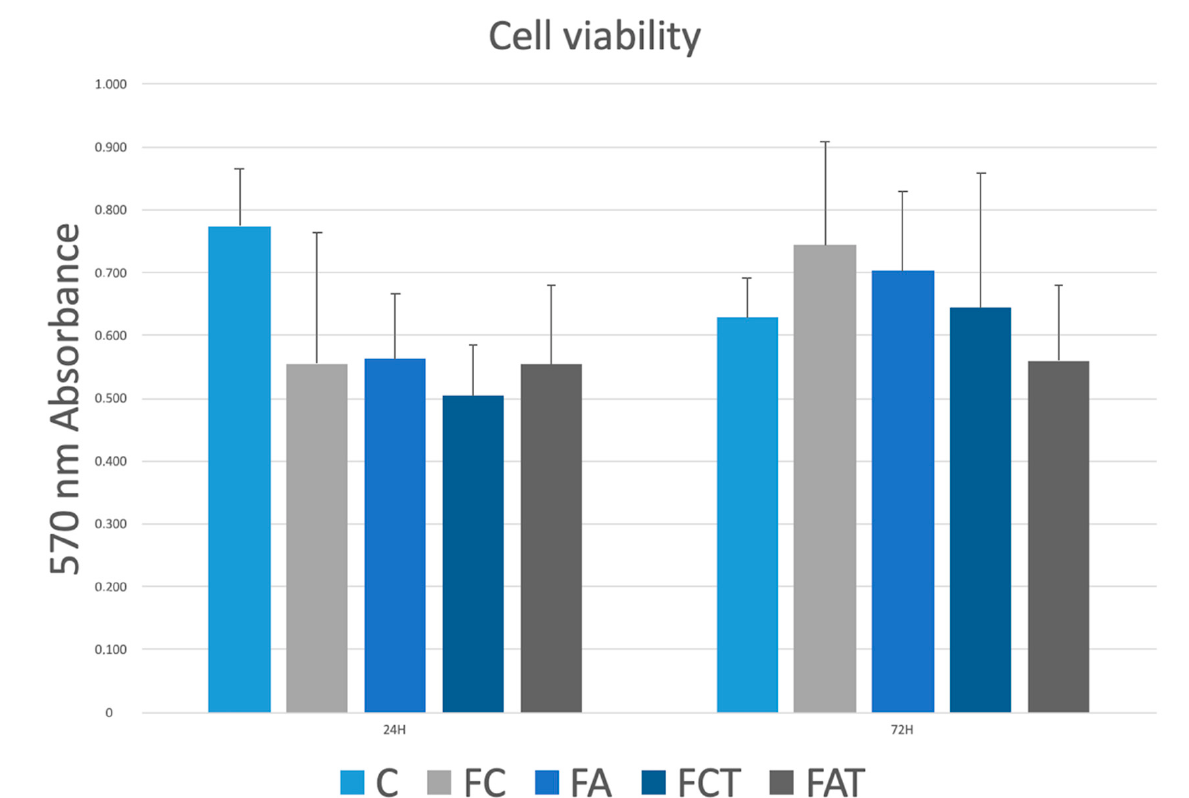
Figure 1. Box plot of cell viability. Cytotoxicity evaluation of materials with MTT method after 24 and 72 h. Cell viability treatment groups had no statistically significant difference to the control group (n = 12).